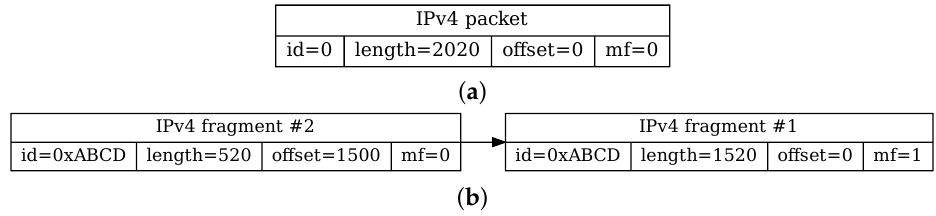
Figure 2. A comparison of a defragmented IP packet ( a ) and corresponding fragment series ( b